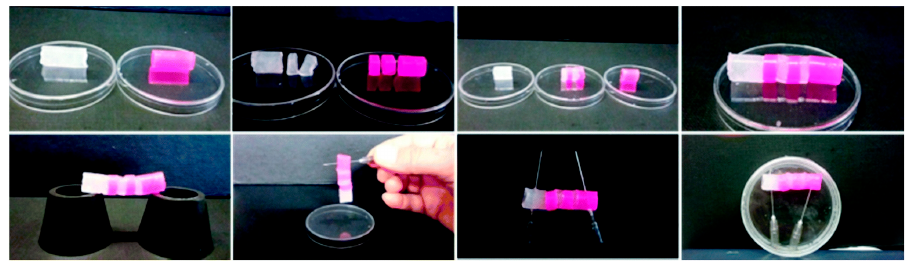
Figure 11. ( Top ) The four images show the sequence followed to prepare the hydrogel bridge (length ≈ 4.0 cm). ( Bottom ) The four images demonstrate that the hydrogel has a self-healing property. The right-end image was taken after one week. Image adapted with permission from reference [57].